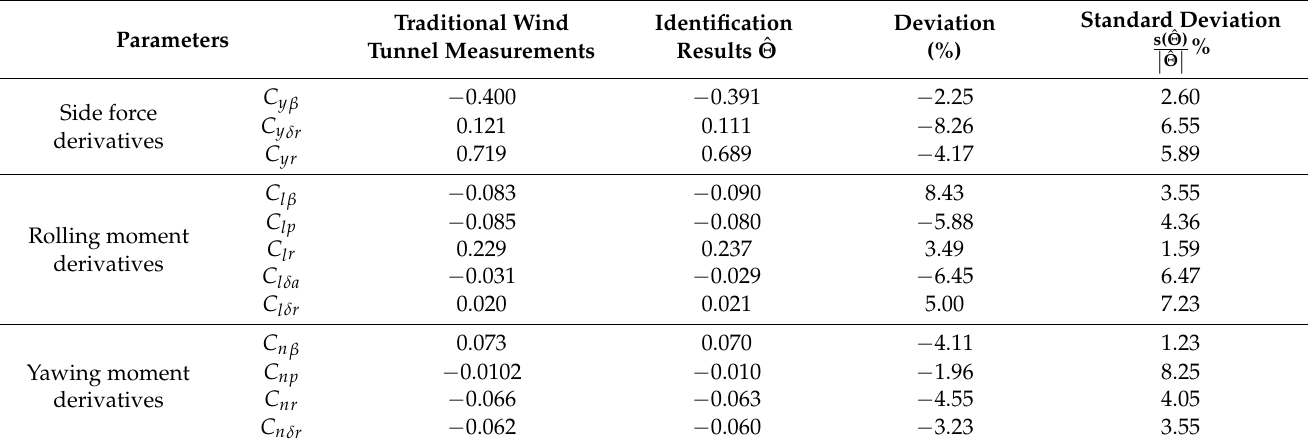
Table 4. Identification results of the lateral-directional aerodynamic